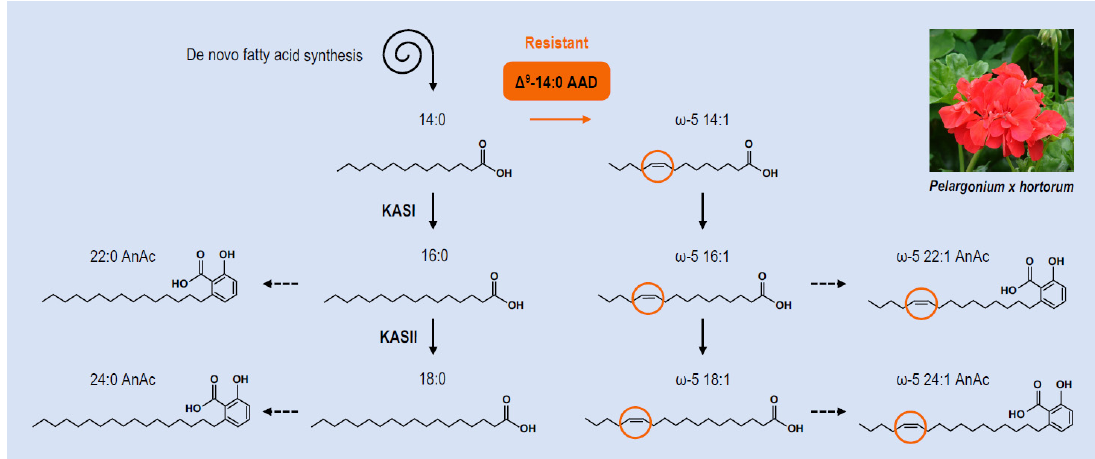
Figure 4. Biosynthesis of anacardic acids in Pelargonium x hortorum. The simplified scheme depicts the different pathways involved in the biosynthesis of fatty acids and omega-anacardic acids (AnAc) in trichomes of Pelargonium x hortorum . Production of myristoleic acid by ∆ 9 -myristoyl–ACP desaturases in resistant genotypes is highlighted in orange. AAD, acyl–acyl carrier protein desaturase; KAS, fatty acid synthase complex comprising 3-ketoacyl–ACP synthase. Picture credit: [115].